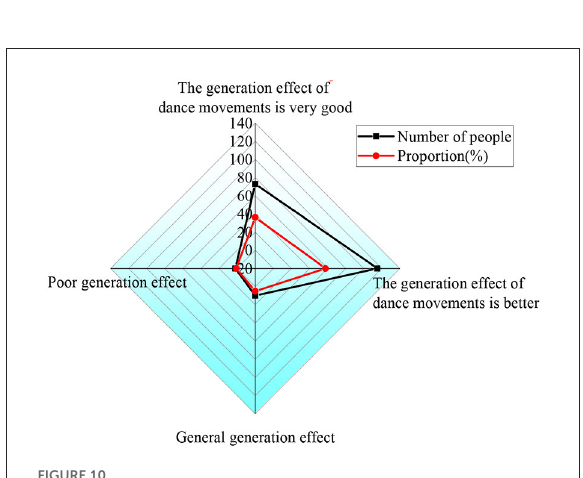
FIGURE10 The dancer’s evaluation of the dance action generation